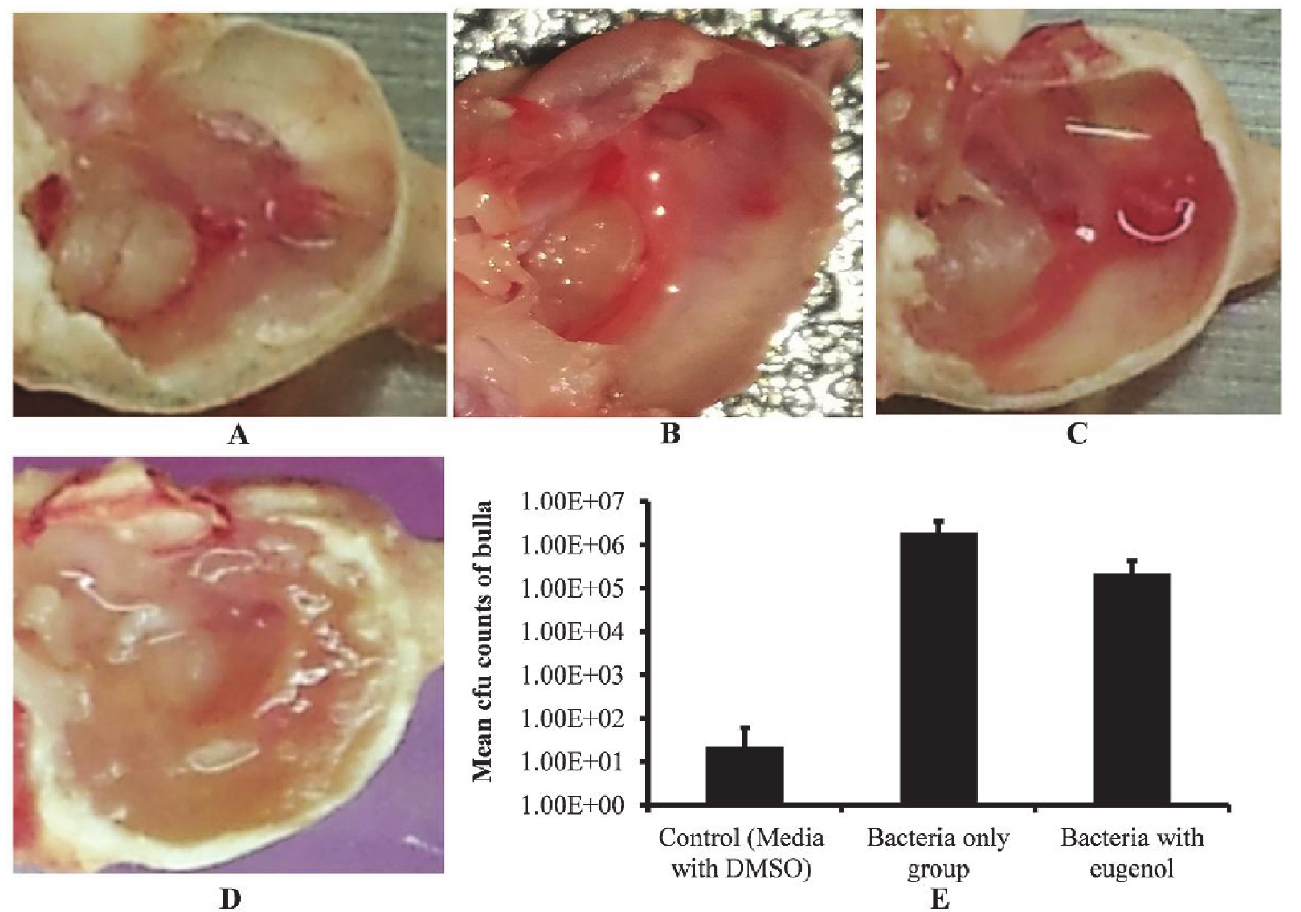
Fig 5. Effect of eugenol on colonization of S. aureus (ATCC 29213) in vivo in the middle ear of rat. (A) Image of no procedure control rat middle ear. (B) Image of rat middle ear inoculated with DMSO (0.1%). (C) Image of rat middle ear inoculated with bacteria and eugenol. (D) Image of rat middle ear inoculated with bacteria only. (E) Mean cfu counts of rat bullas inoculated with DMSO, bacteria only and bacteria with eugenol groups. The values are means of two independent experiments. The statistical significance was calculated using one-way analysis of variance (ANOVA) (P < 0.003).